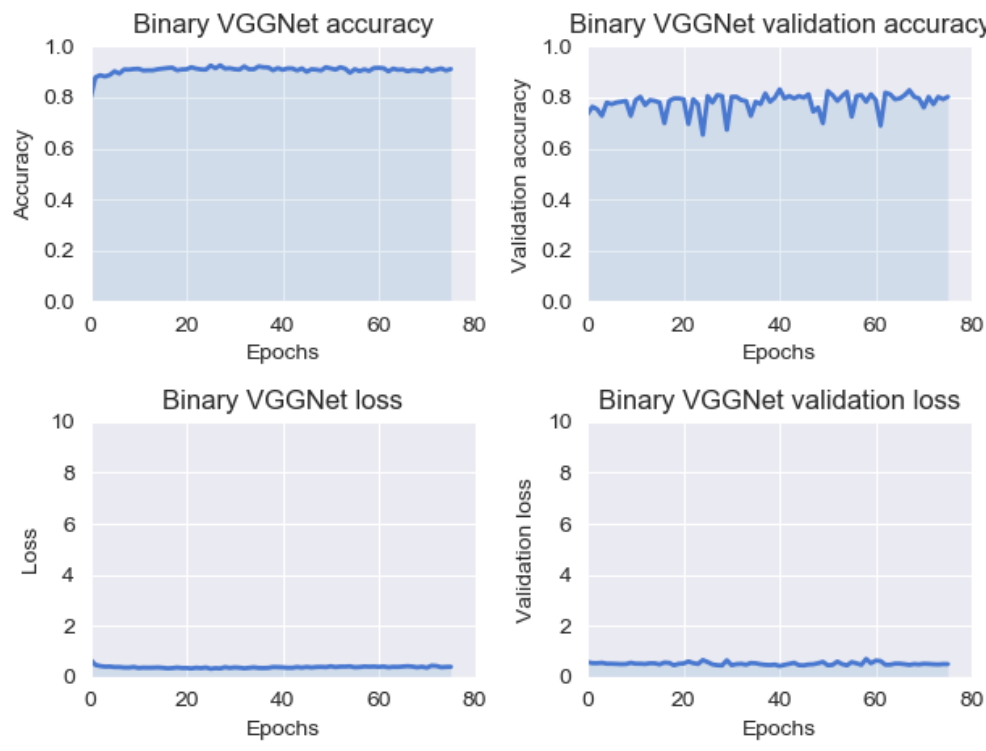
Figure 18. VGG16 binary training statistics. The statistics for the model remain close to static throughout the training phase. Table 15. Confusion matrix for VGG16 binary classification.